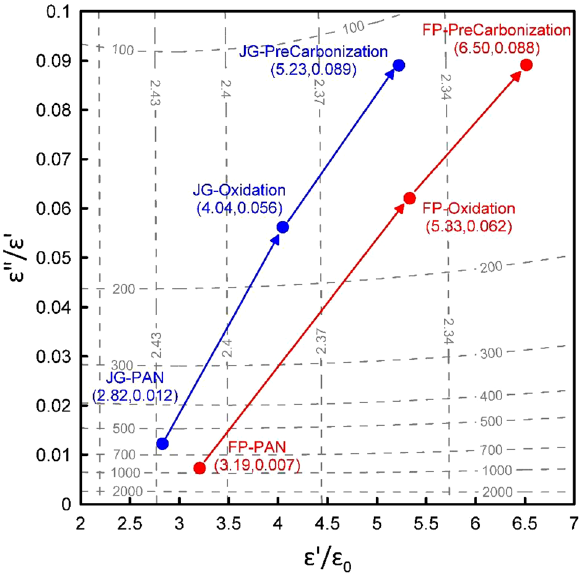
Figure 3. The contour map determines the relative dielectric constant and the loss tangent. Two categories of isolines are obtained from HFSS simulation. Iso-resonant frequency lines and iso- Q -factor lines are plotted with dashed lines. From the measured data as shown in Table 1, we can uniquely determine the relative dielectric constant and the loss tangent as marked in the figure and listed in Table 2.